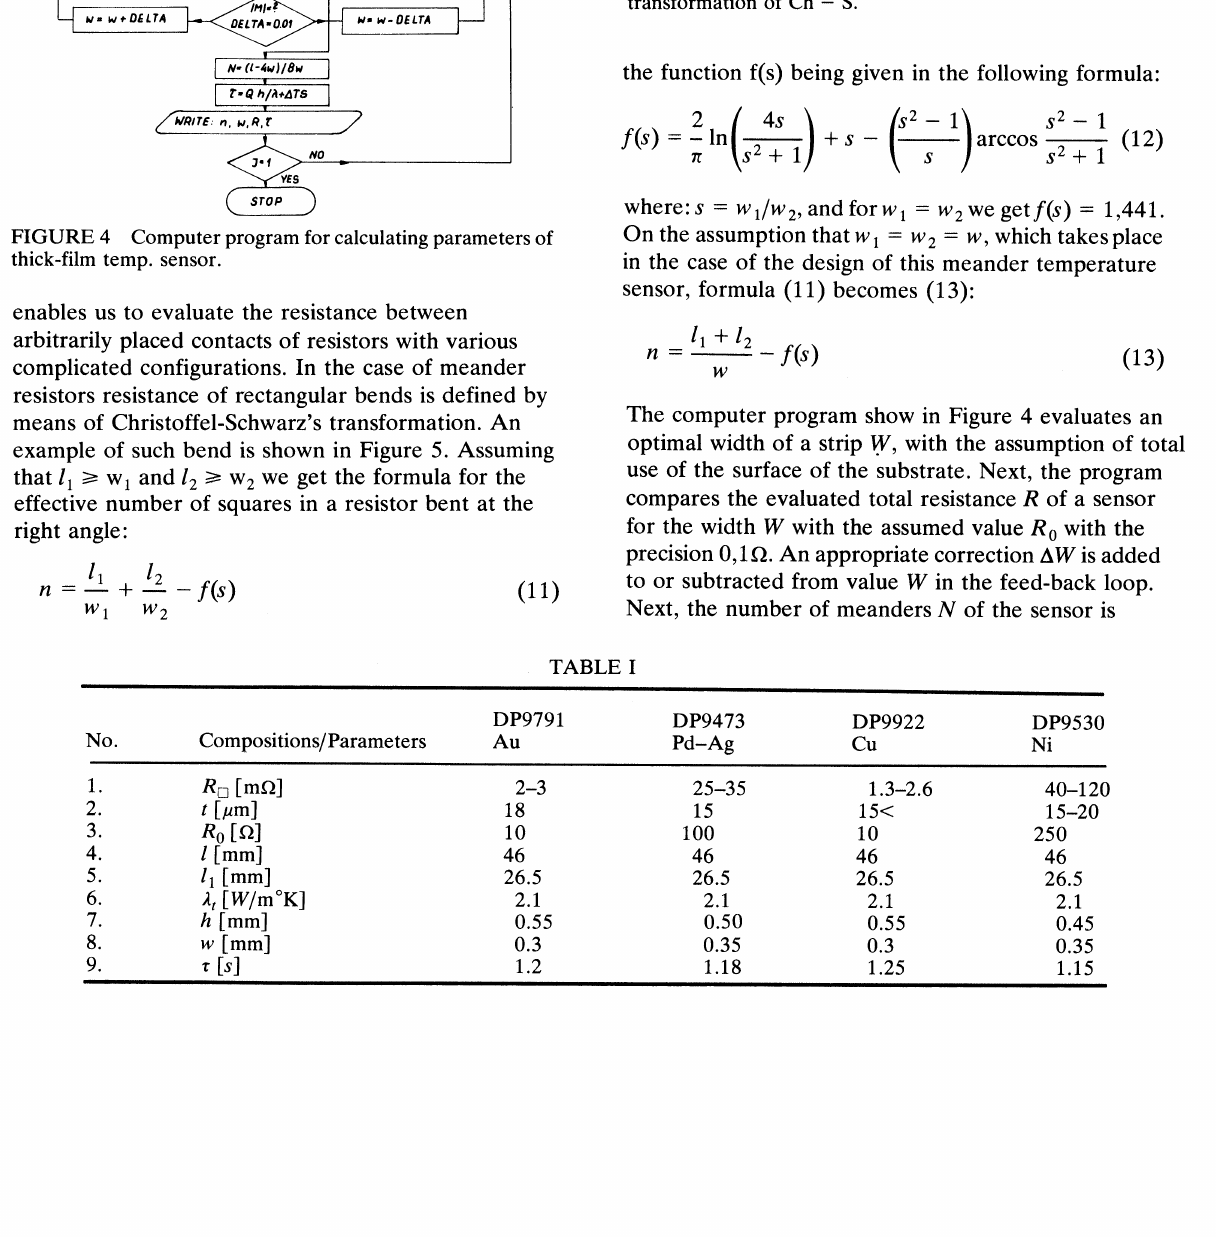
FIGURE 5 a) Fragment of bend in meander resistor, b) First transformation of Ch